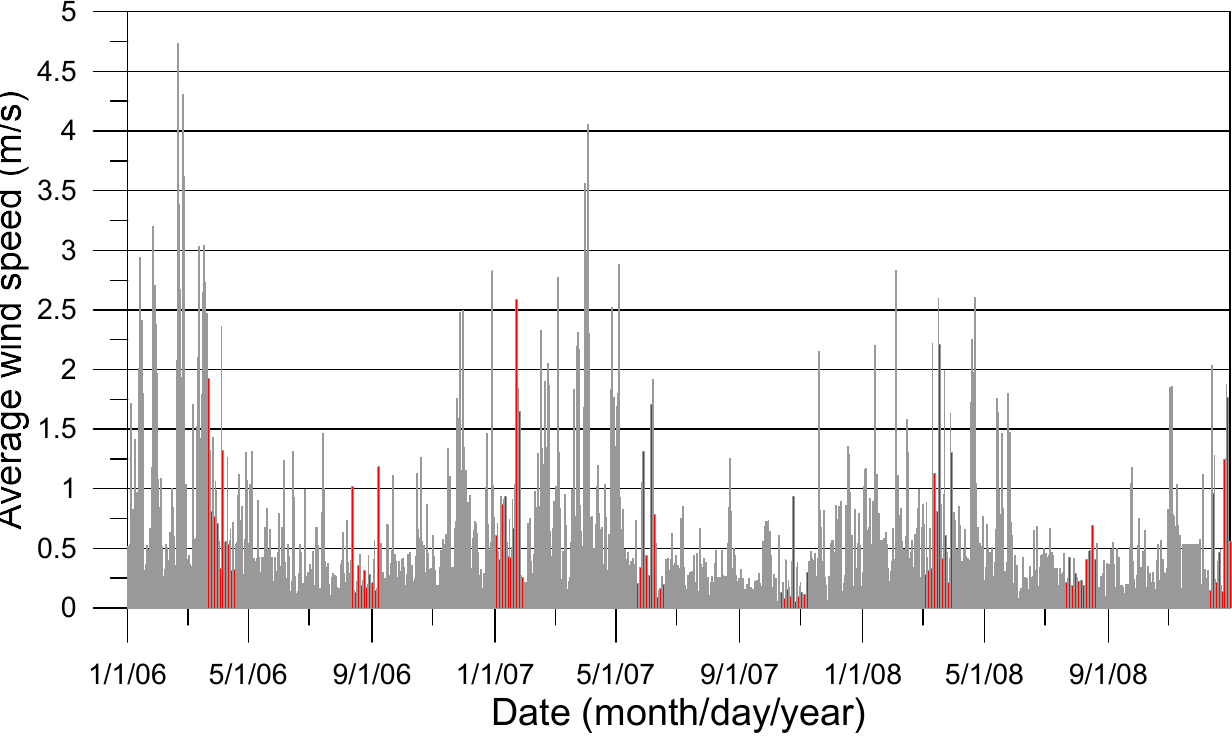
Figure A2. Average daily wind speed 2 m above the ground level at Newbury cutting.